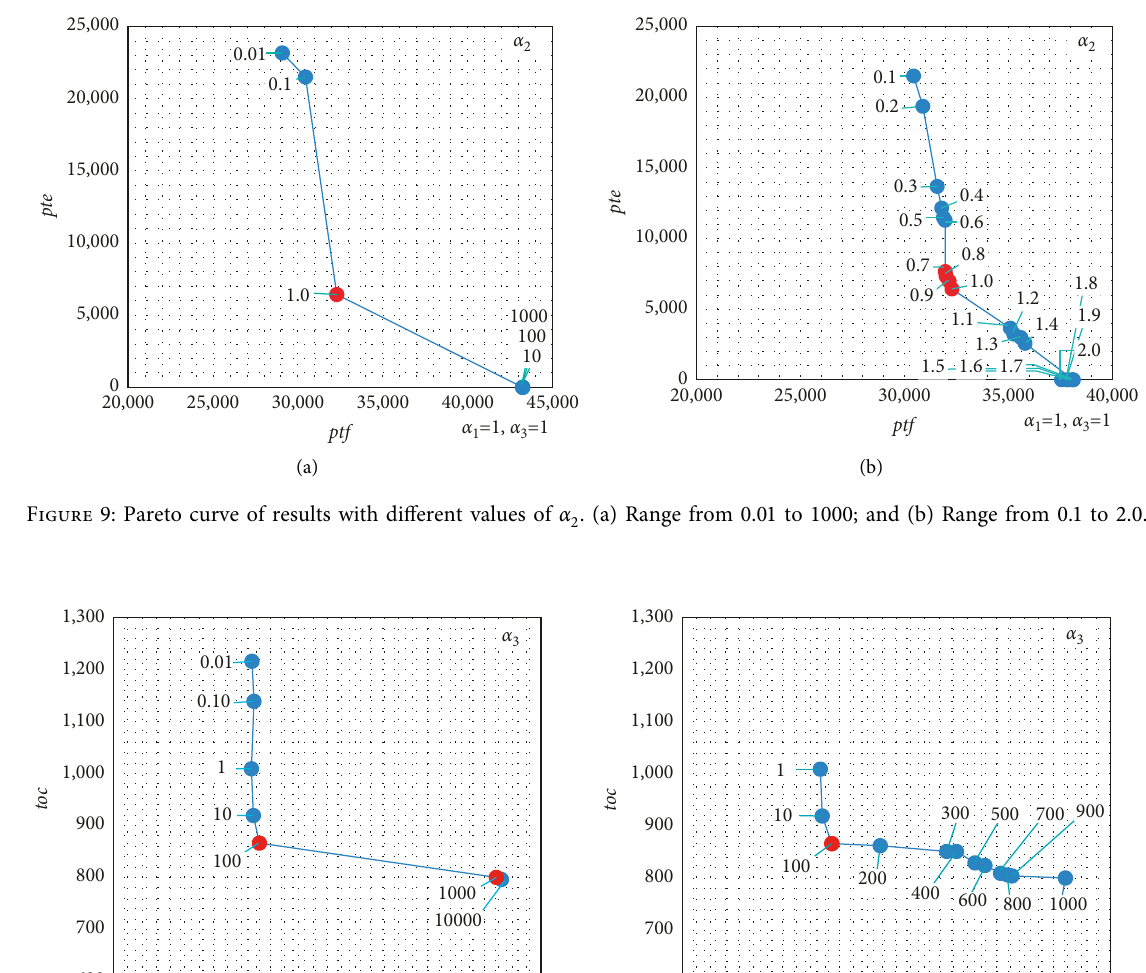
. (a) Range from 0.01 to 10000; (b) range from 1 to 1000. 3